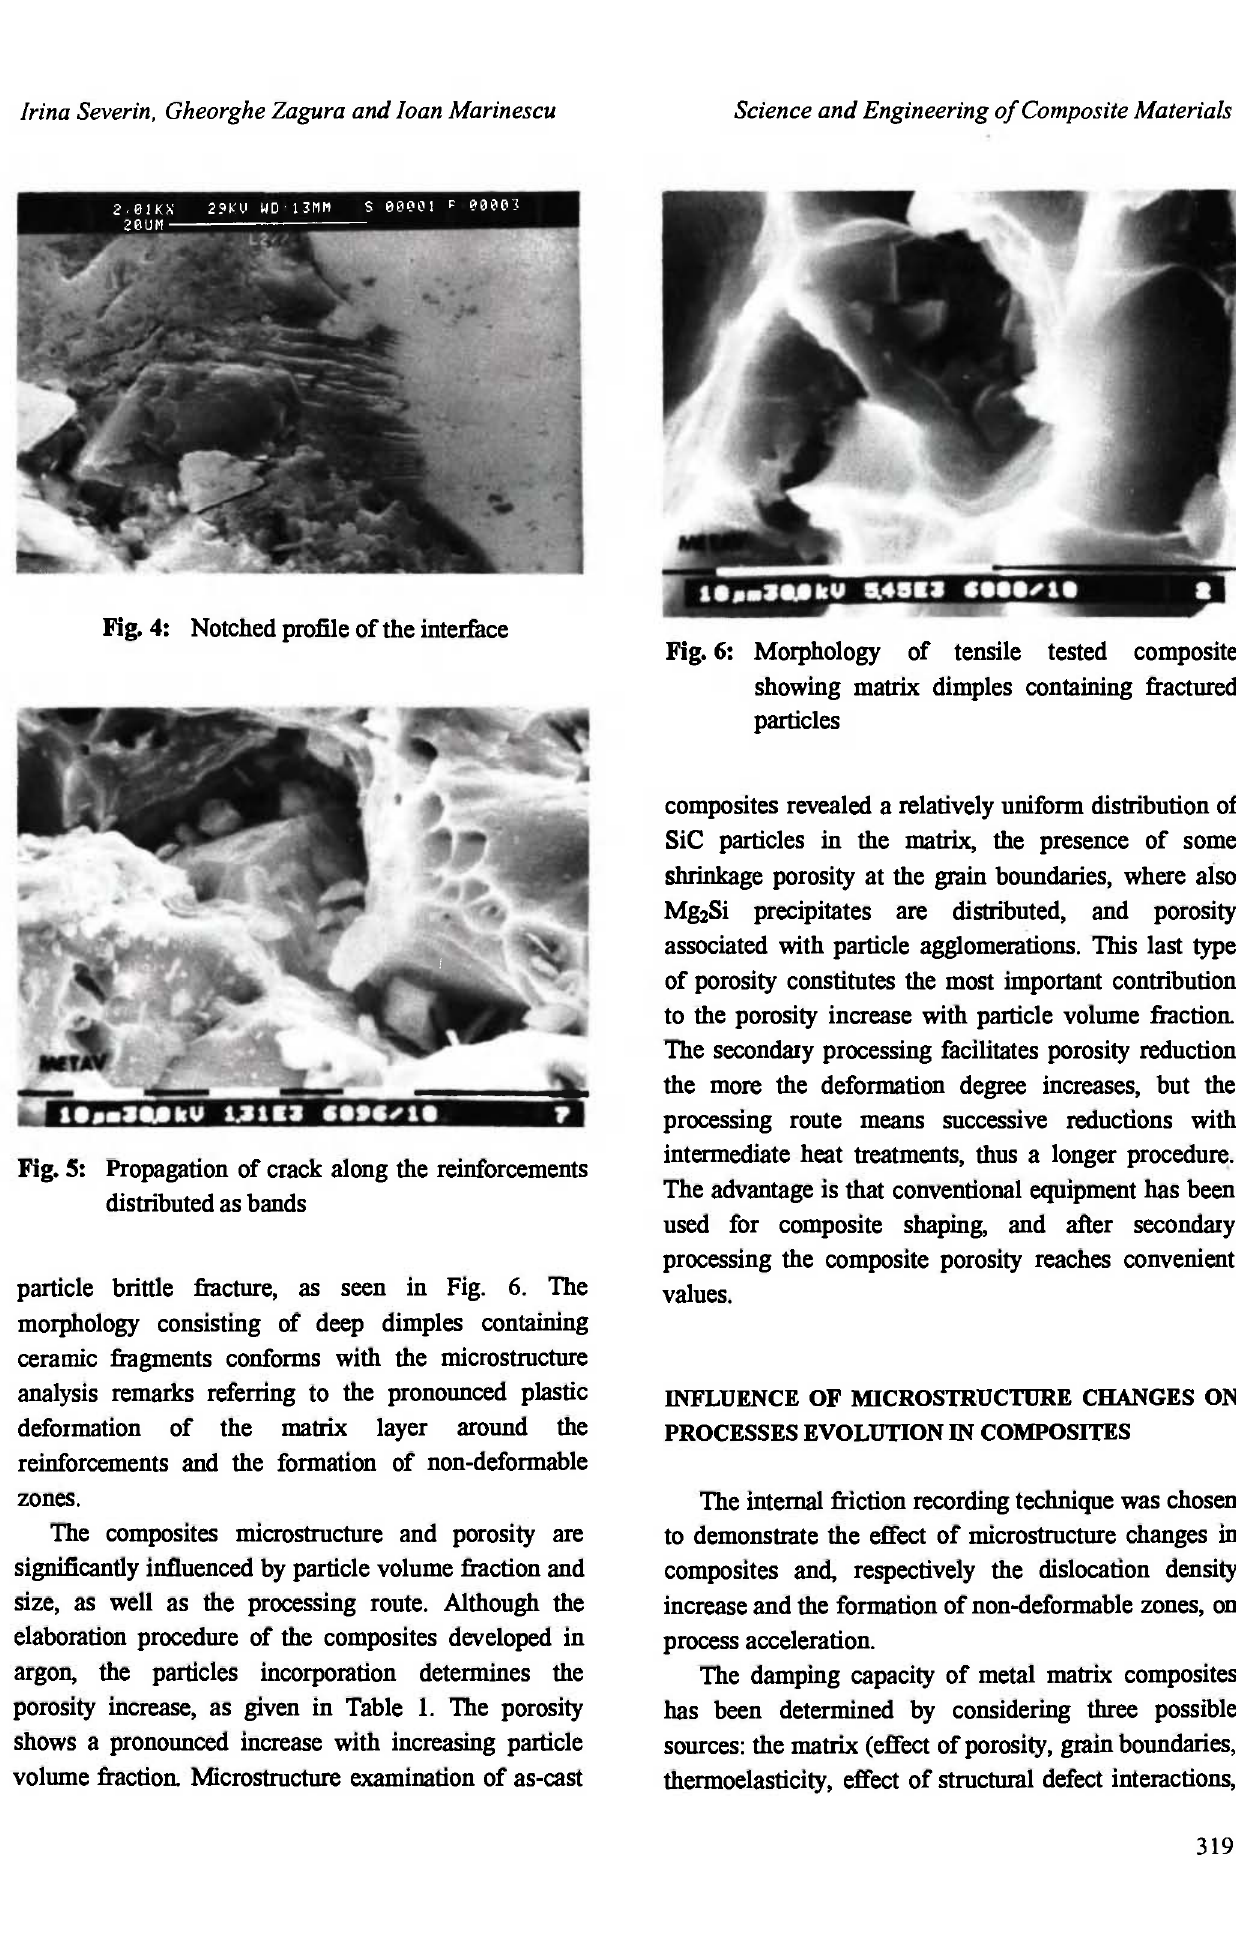
Fig. 6: Morphology of tensile tested composite showing matrix dimples containing fractured particles